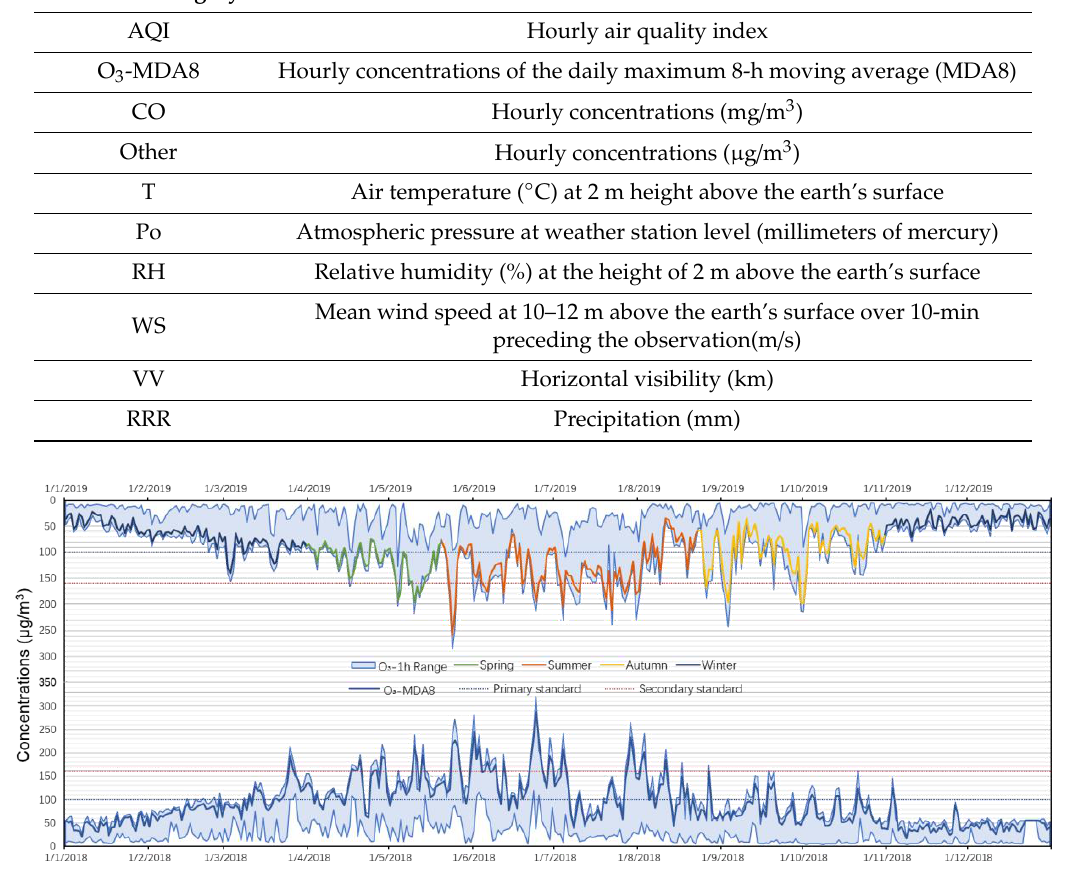
Table A2. Unequivocal definition of pollutants and meteorological parameters.